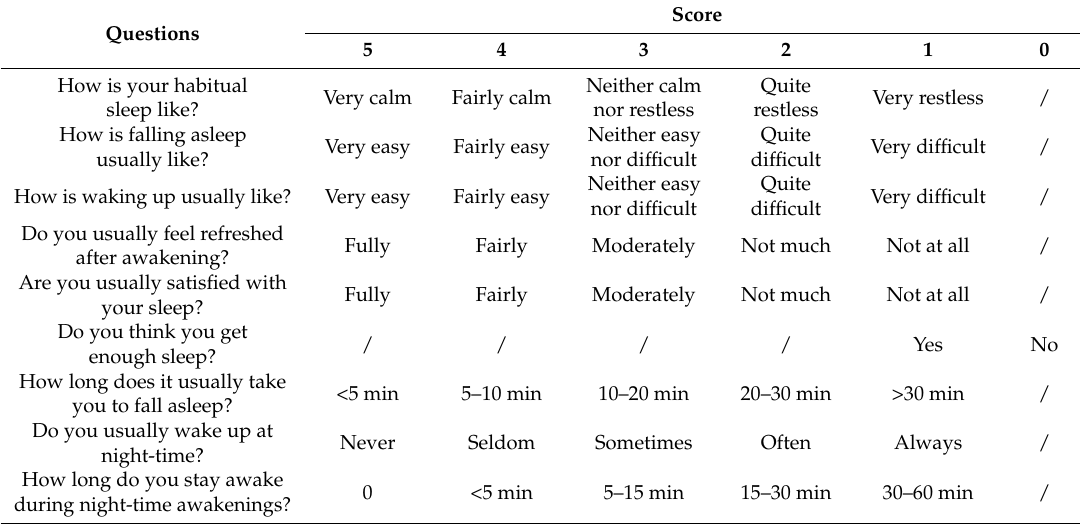
Table 3. Items of the sleep quality